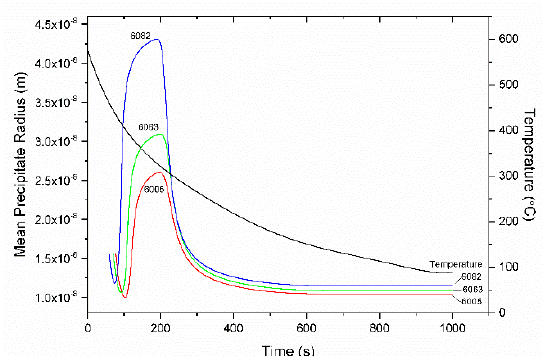
Figure 13. Variation of the mean particle radius of Mg 2 Si precipitates with time during homogenization cooling for 6063, 6005 and 6082 alloys. The cooling curve is also indicated. The particle size distributions (PSD) are shown in Figure 14a–c for 6063, 6005, and 6082 alloys respectively. During the first nucleation event, at 80–100 s particles of smaller diameters continue to